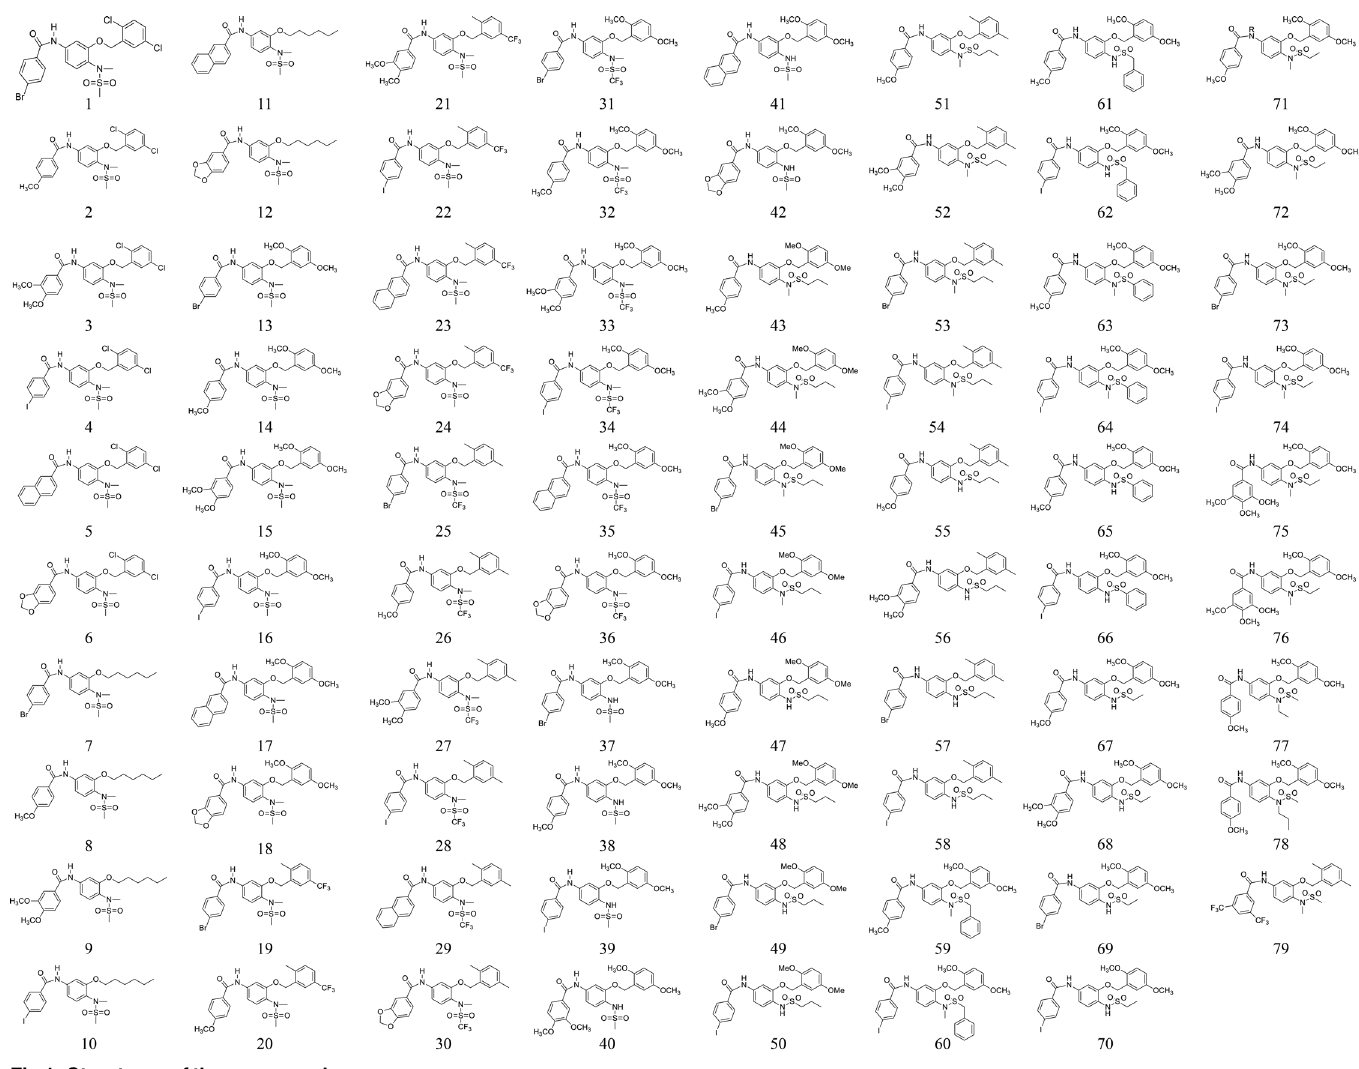
Fig 1. Structures of the